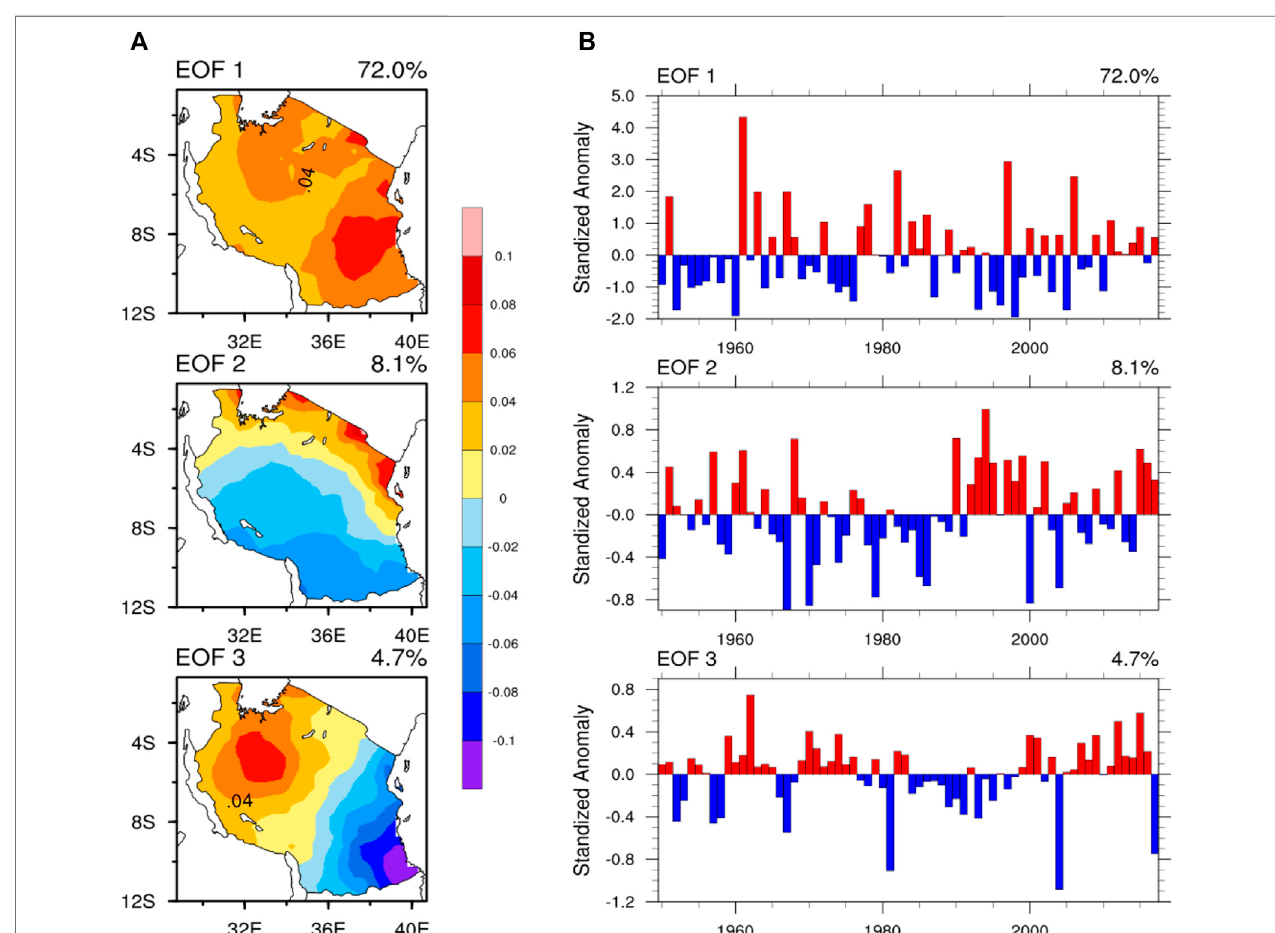
FIGURE 3 | (A) Spatial pattern (mm month − 1 ) and (B) Principal components (PCs) of the fi rst three EOF modes of OND rainfall in Tanzania during 1950 – 2017.